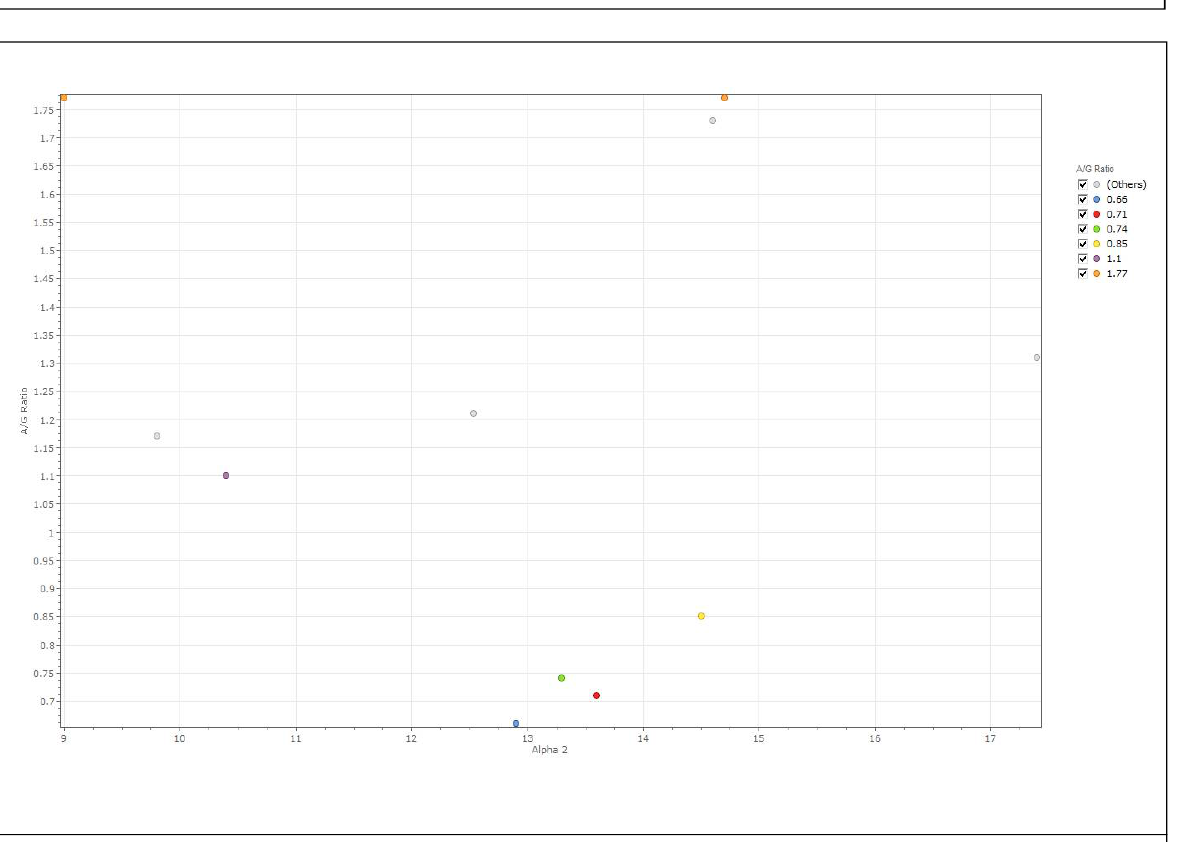
Figure 7: Scatter plot of A/G ratio with respect to alpha